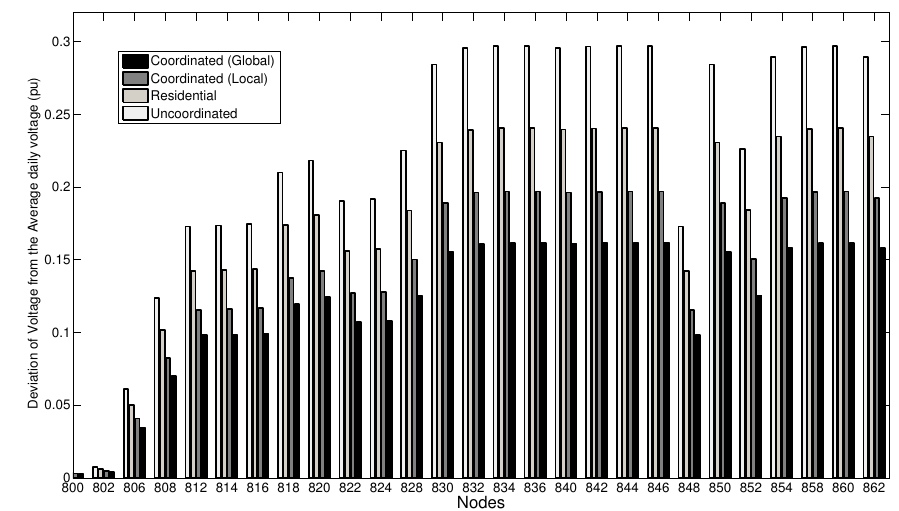
Figure 23. Deviation of voltage from average voltage.